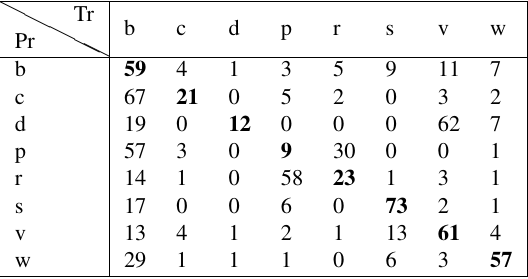
Table 7: Pixelwise accuracy of the image classificationusing the RDF classifier and the watershed segmentation on the eTRIMS 8-class dataset. The confusion matrix shows the classification accuracy for each class (rows) and is row-normalized to sum to 100%. Row labels indicate the true class (Tr), and column labels the predicted class